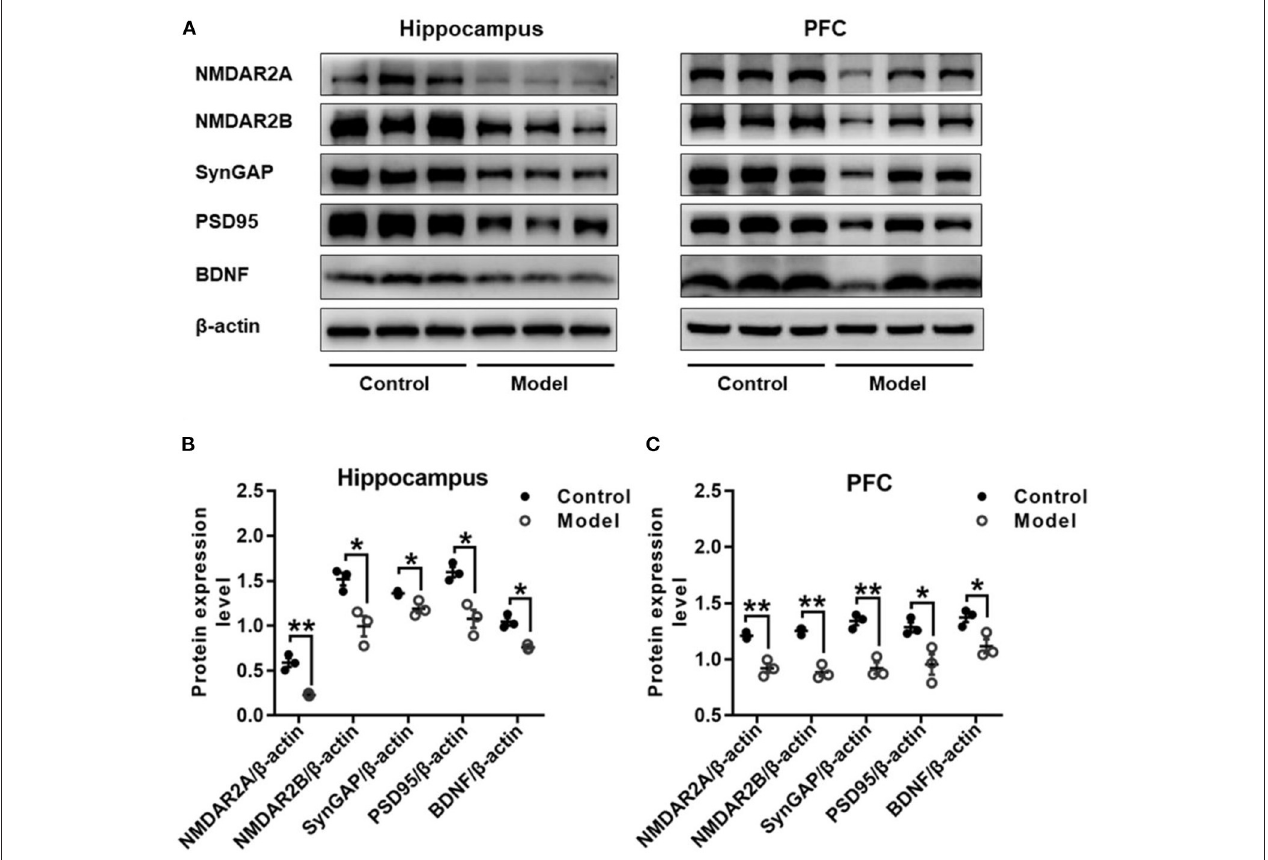
FIGURE 8 | Effects of bilaterally hippocampal injection of STZ on the expression of synaptic plasticity related proteins in the hippocampus and PFC of model mice. Typical graph (A) and statistical analyses (B,C) of the western blot results. Data in (B,C) are presented as the mean ± SEM ( n = 3 for each group). In the hippocampus (A,B) , the expression of NMDAR2A, NMDAR2B, SynGAP, PSD95, and BDNF was all decreased in the model group. The proteins expression situation in PFC is similar to that in hippocampus (A,C) . * P < 0.05, ** P < 0.01; compared with the control